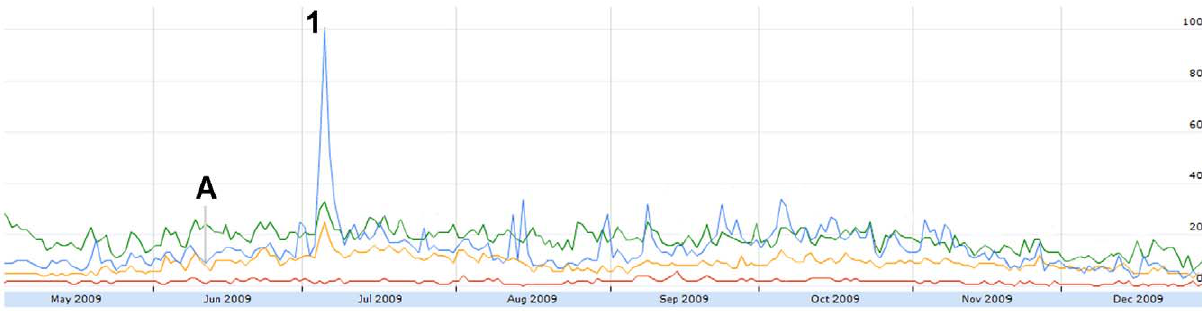
Figure 9. The relative proportion of tweets expressing concern from May 1 to December 31, 2009. Figure was scaled to the highest peak on July 5 where 30.66% of all tweets expressed concern. The peak was assigned a score of 100. Subconcepts: Blue=concern for others. Red=concern for self. Yellow=concerned emoticons. Green=general concern. A=June 11: WHO pandemic level 6 announcement. 1=July 5: Harry Potter actor Rupert Grint has H1N1.